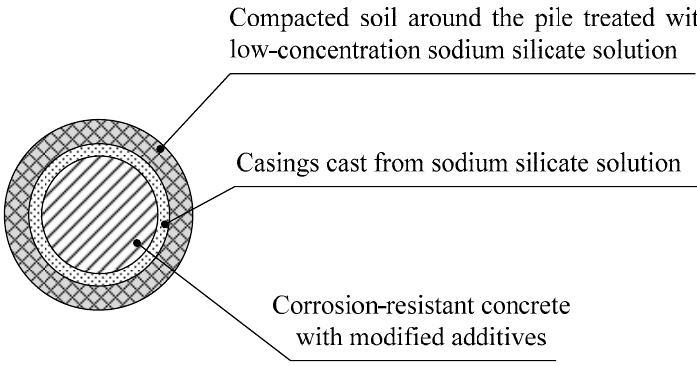
Figure 3. Design of the protective case.